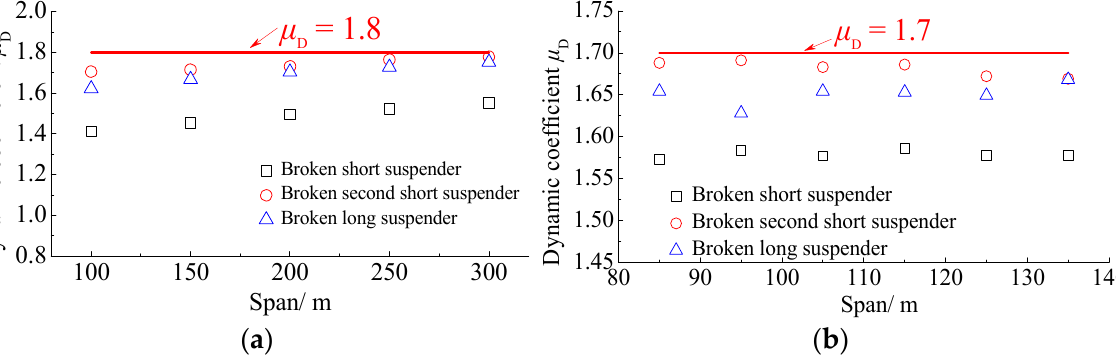
Figure 27. The relationship between the dynamic coefficient and the span length for the suspender: ( a ) half ‐ through CFST standard arch bridges; ( b ) through CFST standard arch bridges.